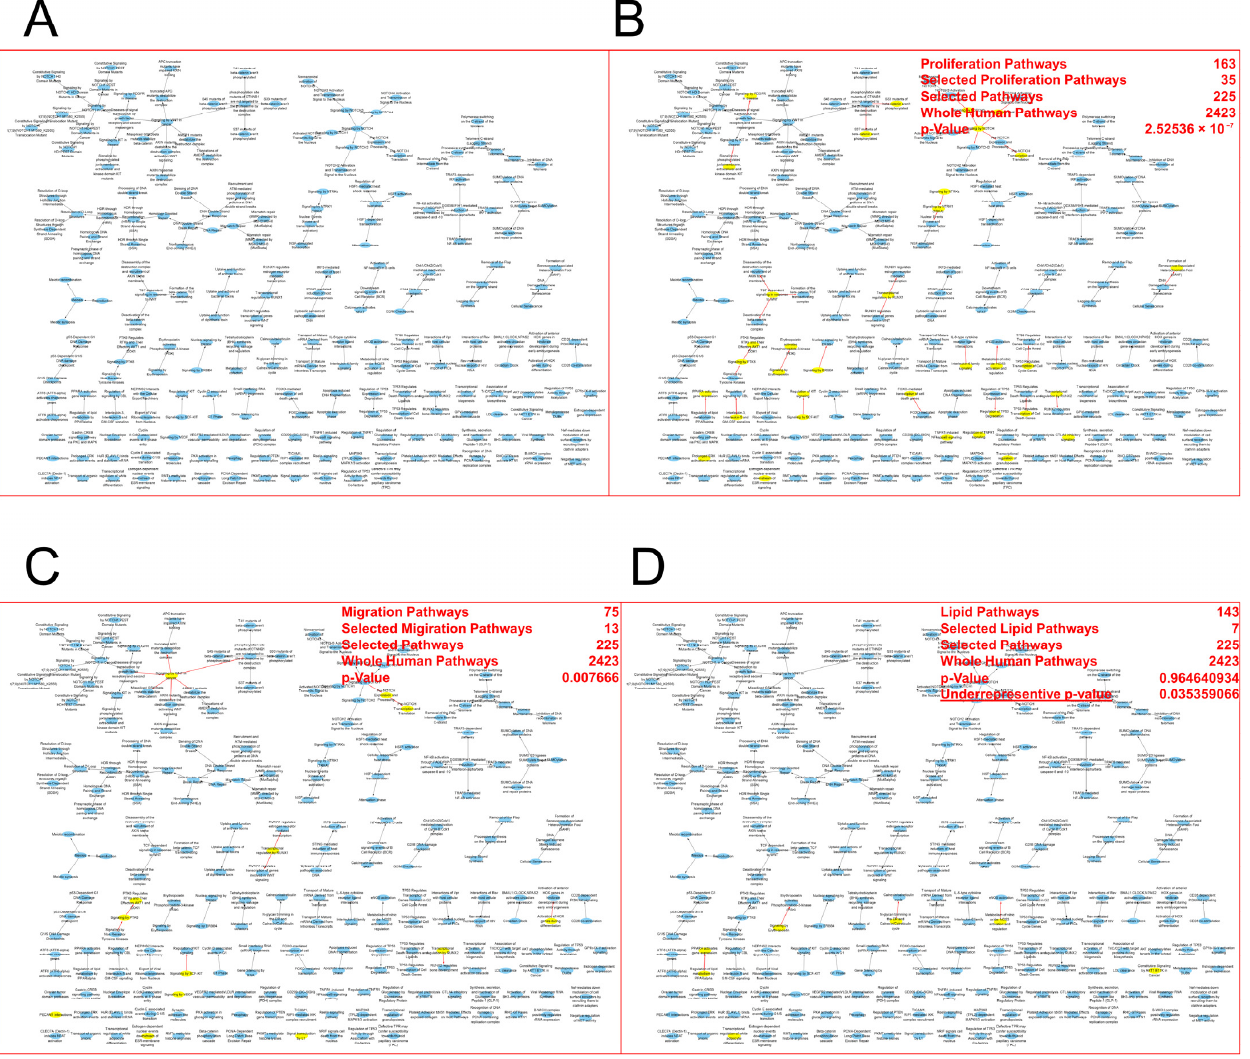
Figure 6. USP15 may repress HCC via genes in cell proliferation and cell migration. HCC-USP15 pathways: network of pathway hierarchies that may contribute to the regulatory role of USP15 in HCC. ( A ) A sub-network of the human pathway hierarchies. Each node has a score s > 20 and hence may contribute to the regulatory role of USP15 in HCC, see text. ( B ) Pathway hierarchies associated to the function “cell proliferation” are highlighted in yellow. The function “cell proliferation” is significantly enriched in the network ( p =2.5 × 10 − 7 , hypergeometric test). ( C ) Pathway hierarchies associated to the function “cell migration” are highlighted in yellow. The function “cell migration” is significantly enriched in the network ( p = 0.0077, hypergeometric test). ( D ) Pathway hierarchies associated to the function “lipid processes” are highlighted in yellow. The function “lipid processes” is significantly underrepresented in the network ( p = 0.035359066, hypergeometric test).